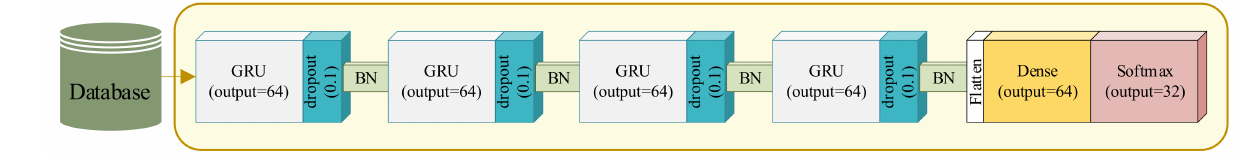
Figure 4. The architecture of the proposed GRU model.